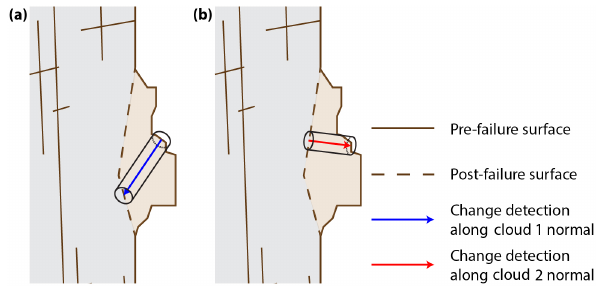
Figure 6. Conceptual variation in the distance along the normal for a rockfall. (a) Change detection along a surface-normal direction estimated from the pre-failure surface (Cloud 1). (b) The normal direction estimated using a planar, post-failure surface more accu- rately represents the direction of change than the post-failure sur- face vector due to the complexity of the pre-failure surface. With both change detections originating in the same approximate posi- tions on the cliff face, the difference in vector lengths illustrates the sensitivity of the 3-D change measurements to the normal estima-